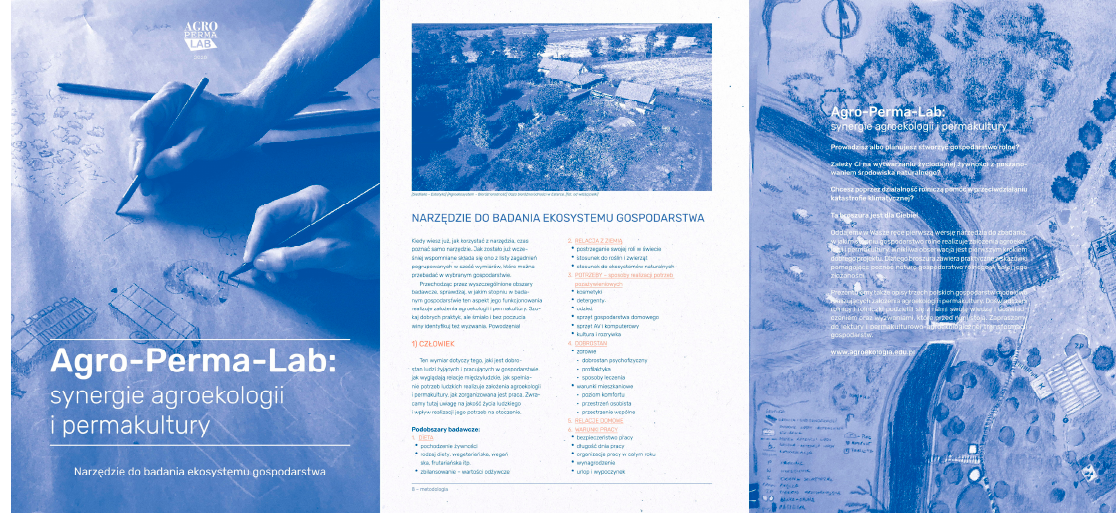
Figure 1. Excerpts from the self-assessment tool for farms prepared by Agro-Perma-Lab (image source: Łukowska, 2020).